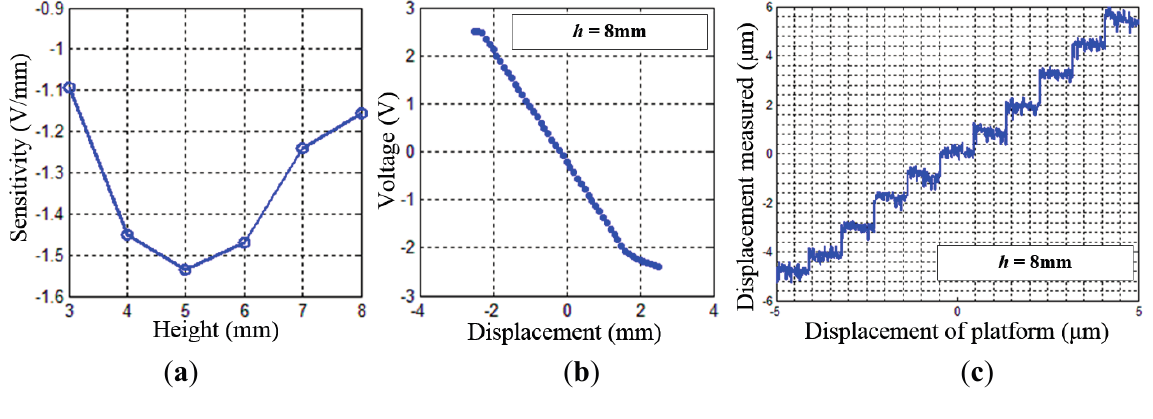
Figure 7. Performance of single Hall sensor: ( a ) Sensitivity on different height; ( b ) Output voltage along measurement direction on the plane of h = 0.8 mm; ( c ) Resolution of the Hall sensor along the measurement